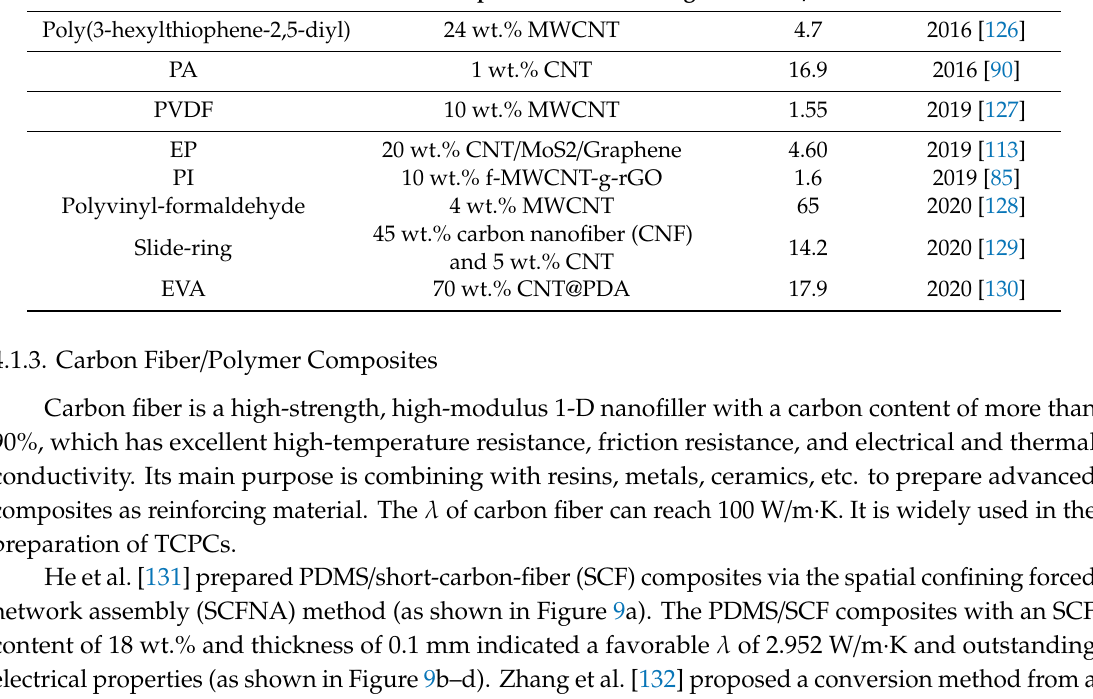
Figure 8. ( a ) Schematic illustration of the preparation of the nano-fibrillated cellulose / fluorinated carbon nanotubes (NFC / FCNT) composites films. ( b ) The cross-sectional morphology of NFC / (35 wt.%) FCNT. ( c ) λ of NFC / FCNT. ( d ) Volume electrical resistivity of NFC / FCNT and NFC / CNT composites films (reproduced with permission from [125]).